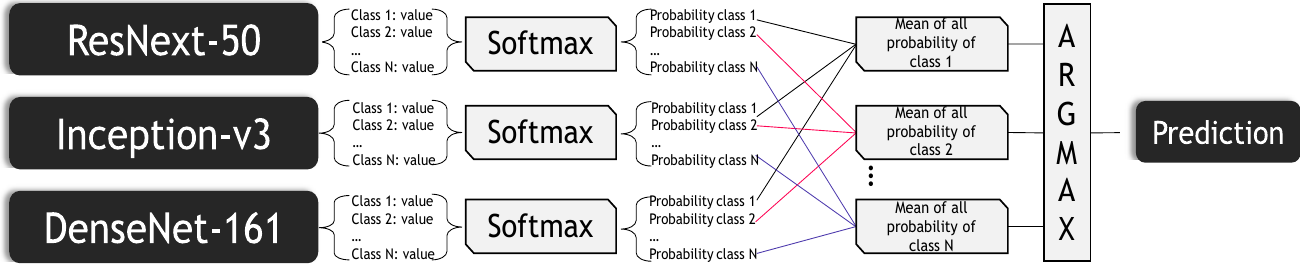
Figure 8. The architecture of our proposed Ensemble-CNNs